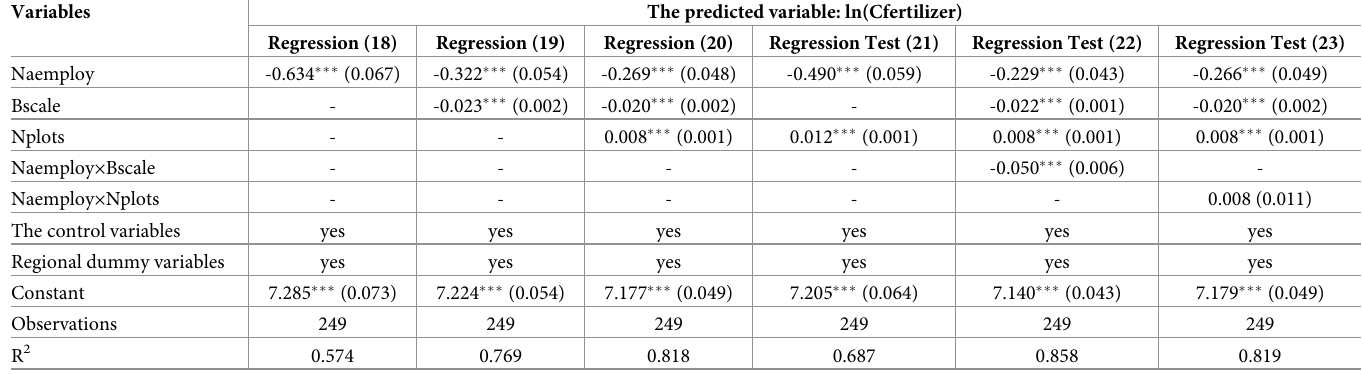
Table 7. Robustness test of the benchmark